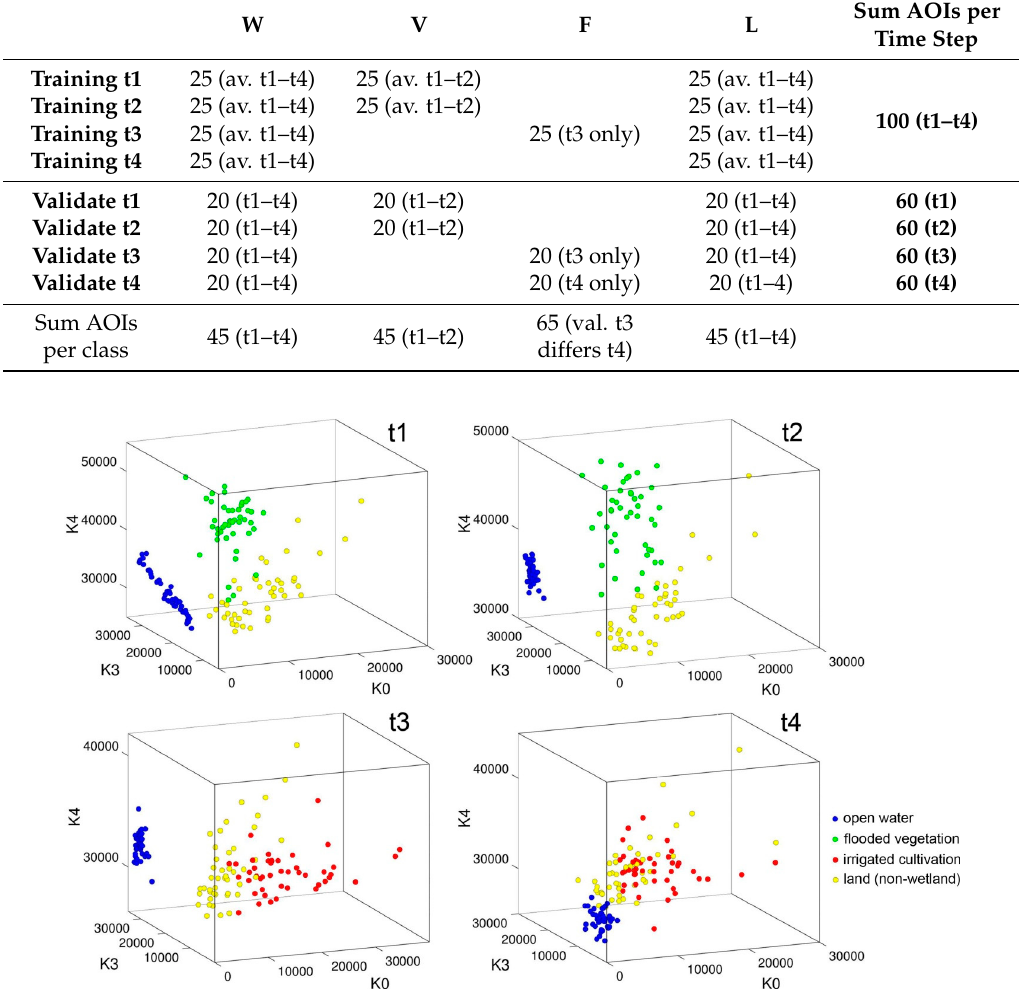
Figure 5. Scatterplots for the Kennaugh elements K 0 , K 3 , and K 4 displaying the mean value of each class of all 135 training and validation areas per time step: open water (blue), flooded vegetation (green), irrigated cultivation (red), and land (yellow), for four time steps (t1–t4). The Kennaugh elements are displayed in normalized scaling to 16 bit unsigned integer.